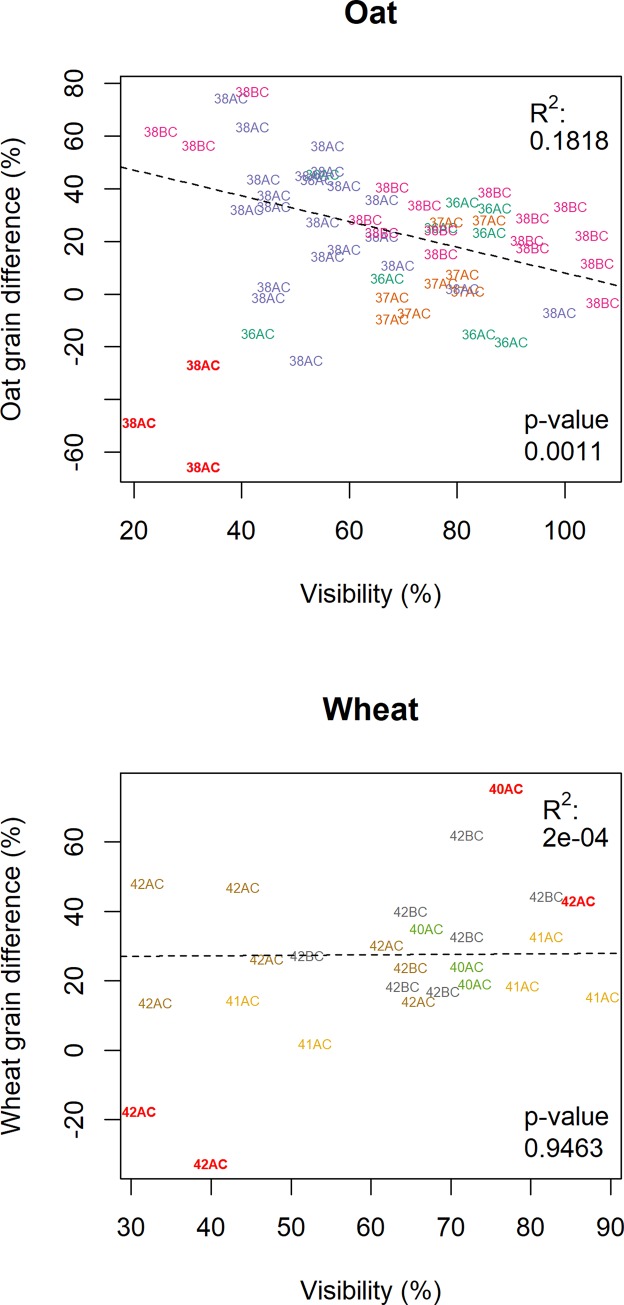
Correlation between grazing intensity and the visibility of the sampling spot for the studied crops.Each alphanumerical code corresponds to fields in Figs 1 and 2. Red bold character indicates the identified outliers.